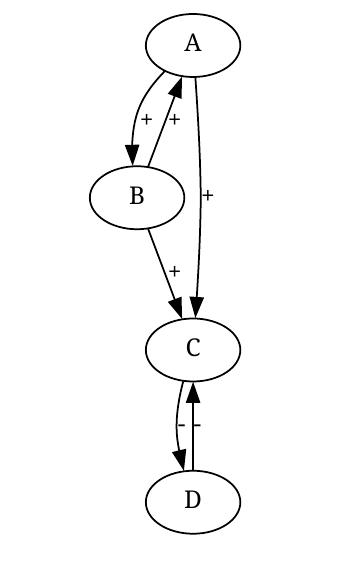
Figure 3 – Influence graph of the example BN for